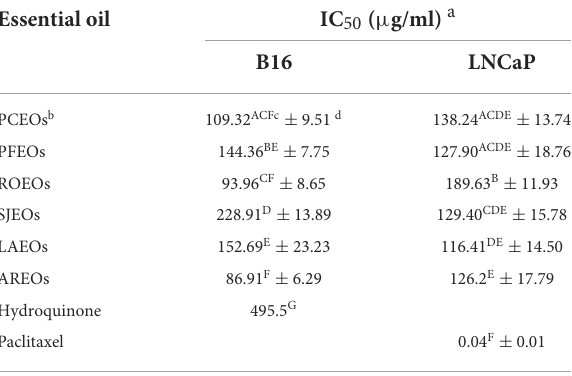
TABLE 3 Antitumor activity of six Lamiaceae plants essential